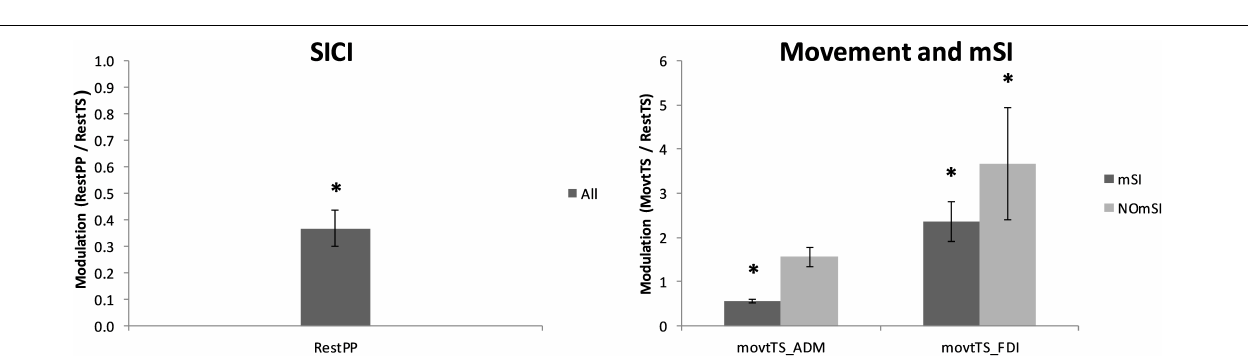
FIGURE 2 | Averaged TEP at RestTS condition ( n = 20). Upper panel: TEP in the centro-medial region (ROI3) (mean ± SE). Lower panel: topographic representation of current source density (CSD) for the main TEP peaks (yellow, positive values; blue, negative values).